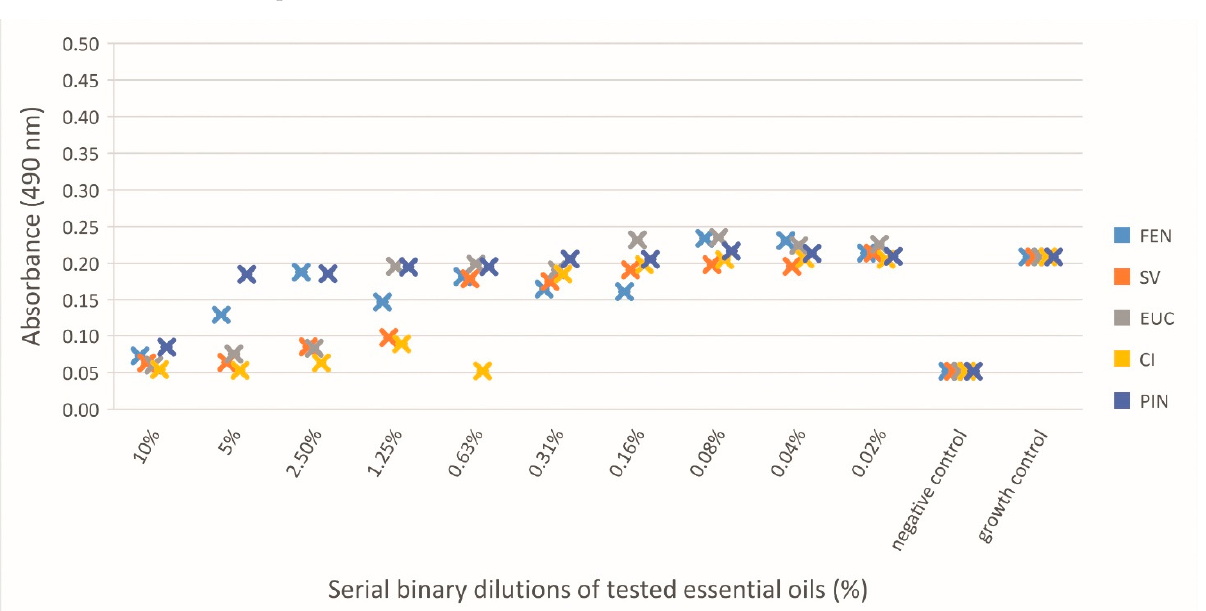
Figure 8. Graphical representation of the MCBE values for Gram-positive Staphylococcus aureus ATCC25923 strain; FEN (fennel EO); SV (sage EO); EUC (eucalyptus EO); CI (thyme EO); PIN (pine EO).